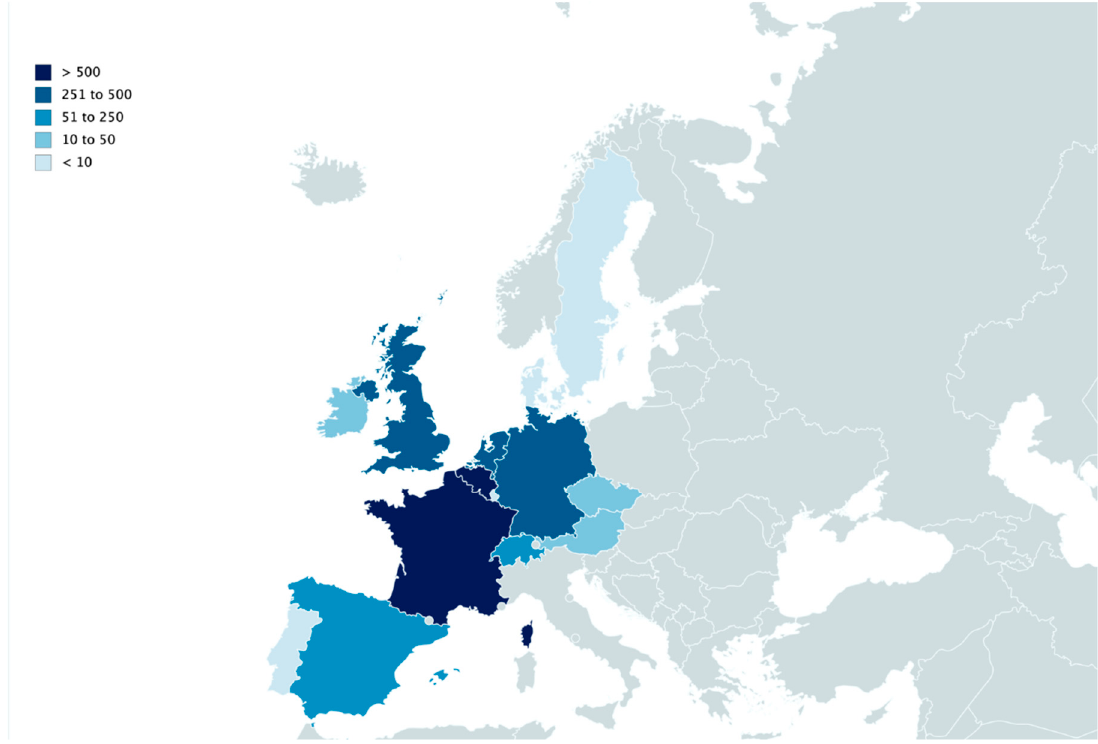
Figure 1. European distribution of atypical myopathy cases notified to the disease surveillance networks from autumn 2006 to November 2019.